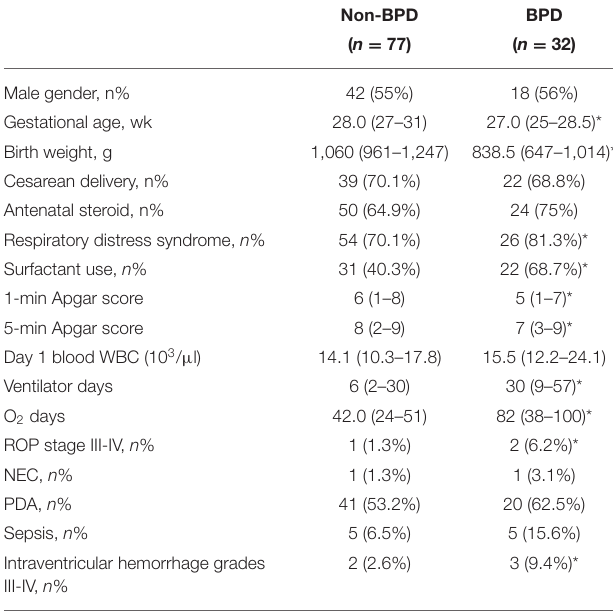
TABLE 1 | Demographic characteristics and clinical